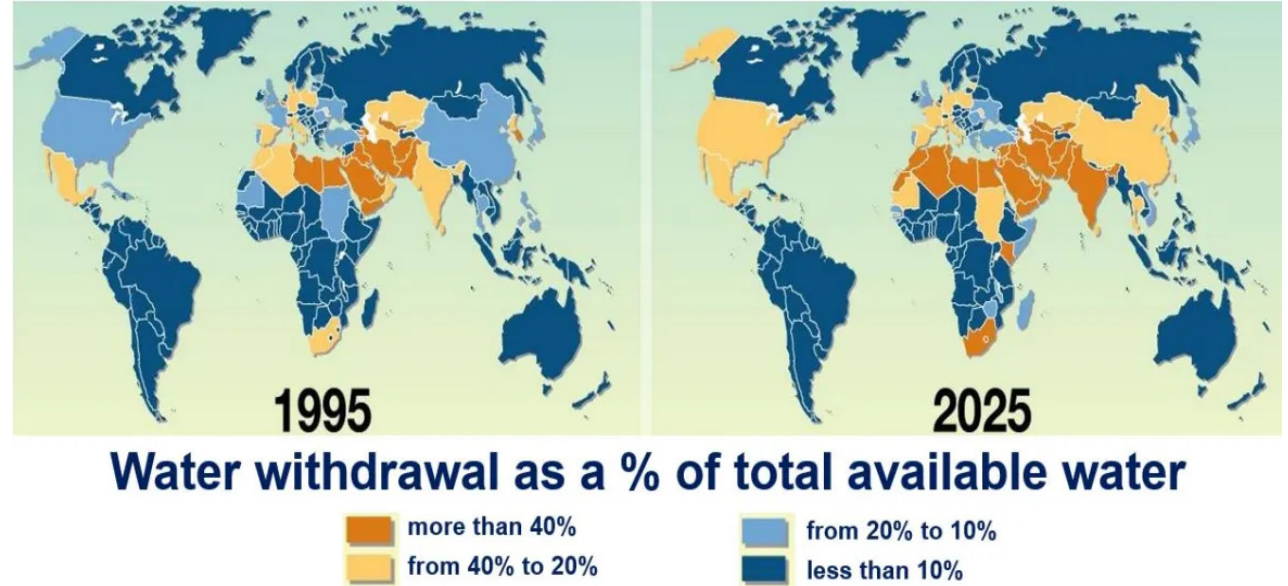
Figure 3. Water withdrawal as a percentage of total available.